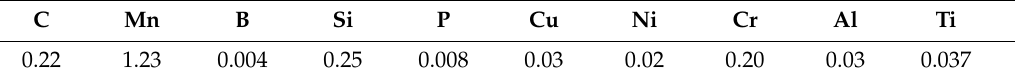
Table 1. Chemical composition of Usibor 1500P (wt.%).